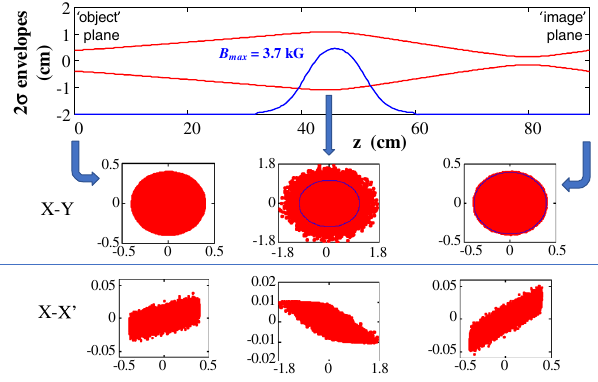
FIG. 3. Numerical simulation with VACO [12] of the propaga- tion of a beam with the initially uniform spatial density distribution and Gaussian velocity distribution through a mag- netic lens. For the phase space portraits, units are centimeters for X and Y, and radians for X ’ .